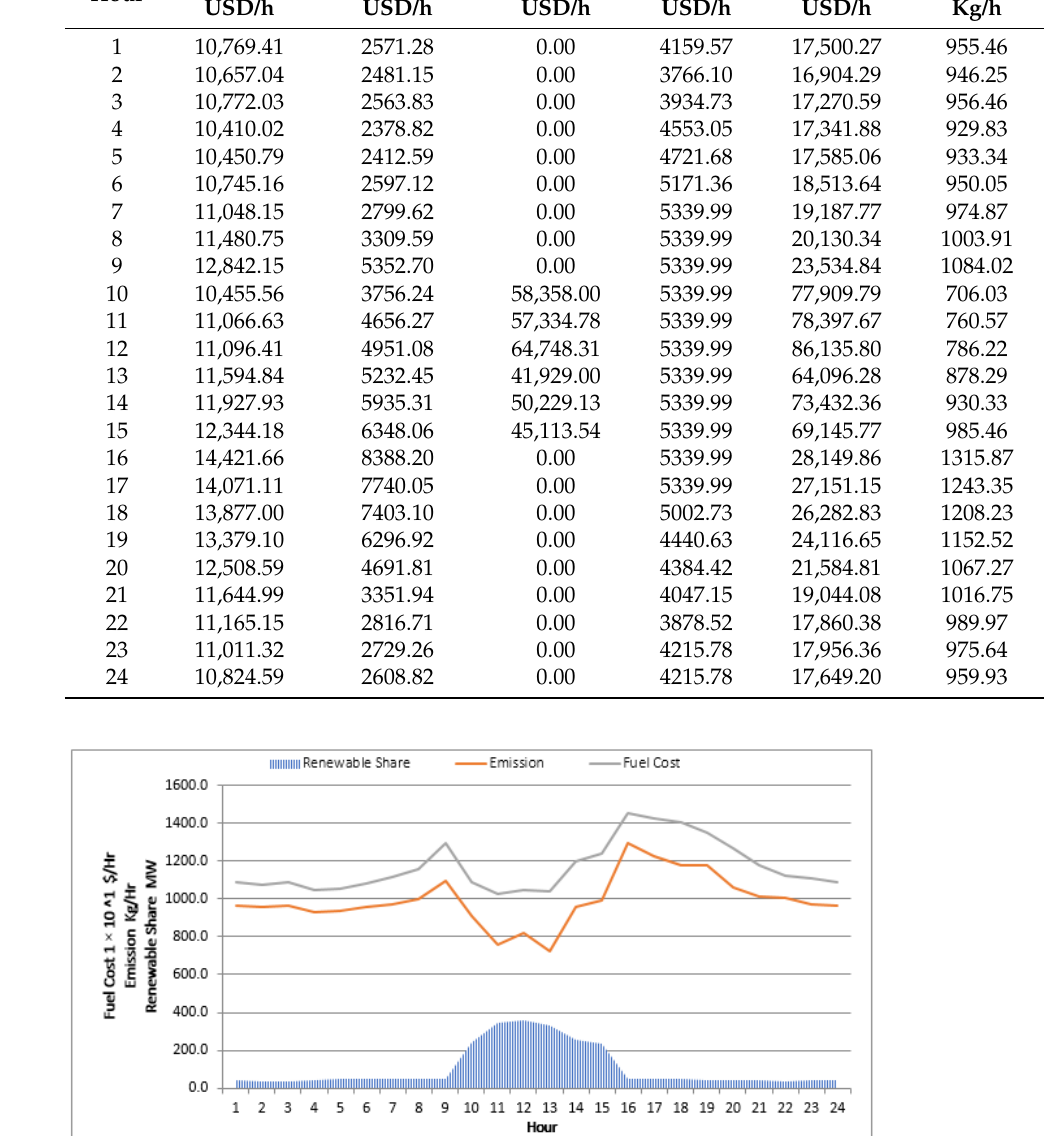
Figure 9. Effect of integrating RES on fuel costs and emissions — case study